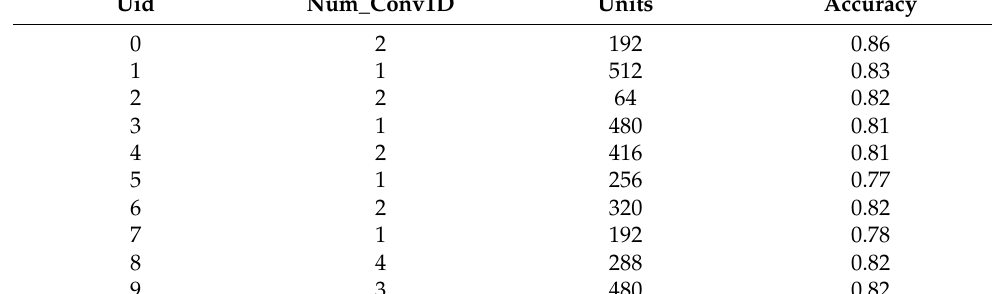
Table 11. Hyperparameter tuning results for the classification of solutions from non-solutions.